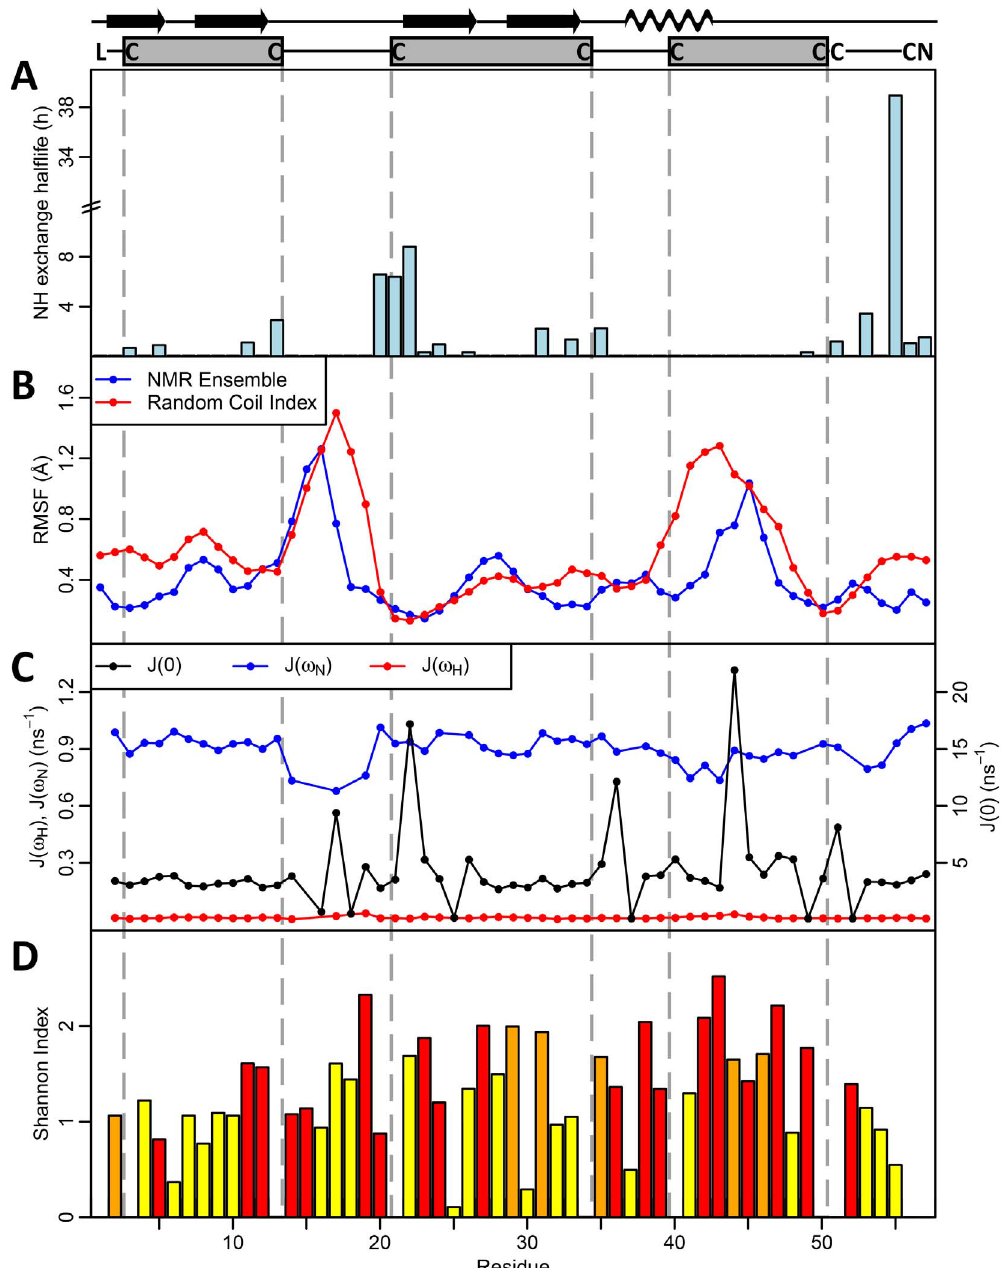
Figure 4. Measurements of structural and sequence variability in PMF. (a) Backbone amide (H N ) exchange H/D exchange rates measured by half life (in hours), with proline residues omitted; (b) Root mean squared fluctation (RMSF) per residue in the PMF structural ensemble (blue) and predicted from the random coil index (red); (c) spectral density functions at 0, v N , and v H ; J(0) is sensitive to fast (ns) and slow ( m s-ms) motions, J( v N ) to motiions on time scales faster than (1/ v N =2 ns), and J( v H ) to motions faster than 1 H (1/ v H =0.2 ns); (d) Sequence variability (Shannon entropy index) at each residue measured for all Class I PMFs, shaded according to likelihood of positive selection at each position (red p , 0.01, orange p , 0.05; yellow=neutral selection). Seven out of the nine non-conserved amino acids in finger 3 display signatures of positive selection, suggesting combined structural flexibility and rapid evolution in this region. doi:10.1371/journal.pone.0096975.g004 While this subset of PMF isoforms activated VNO neurons and regions of the female brain classically involved in pheromone